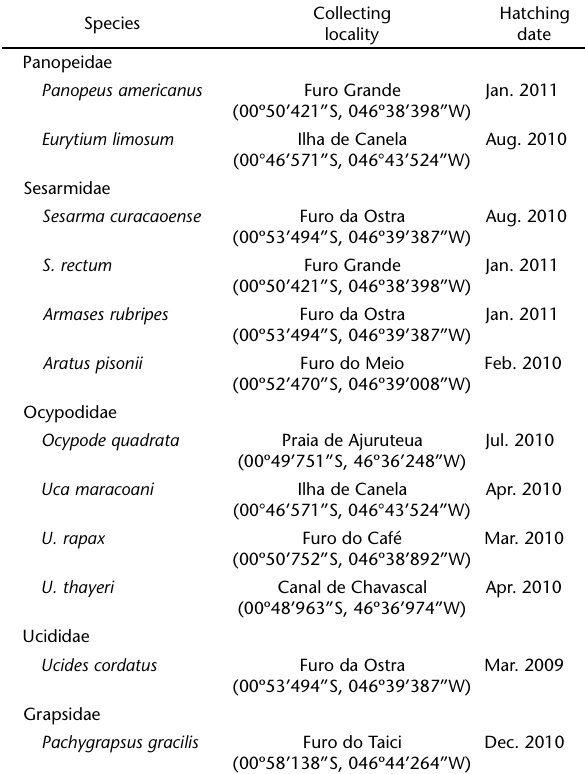
Table I. Collecting locality and hatching date of species obtained at the Caeté River estuary, Pará, Brazil. Species